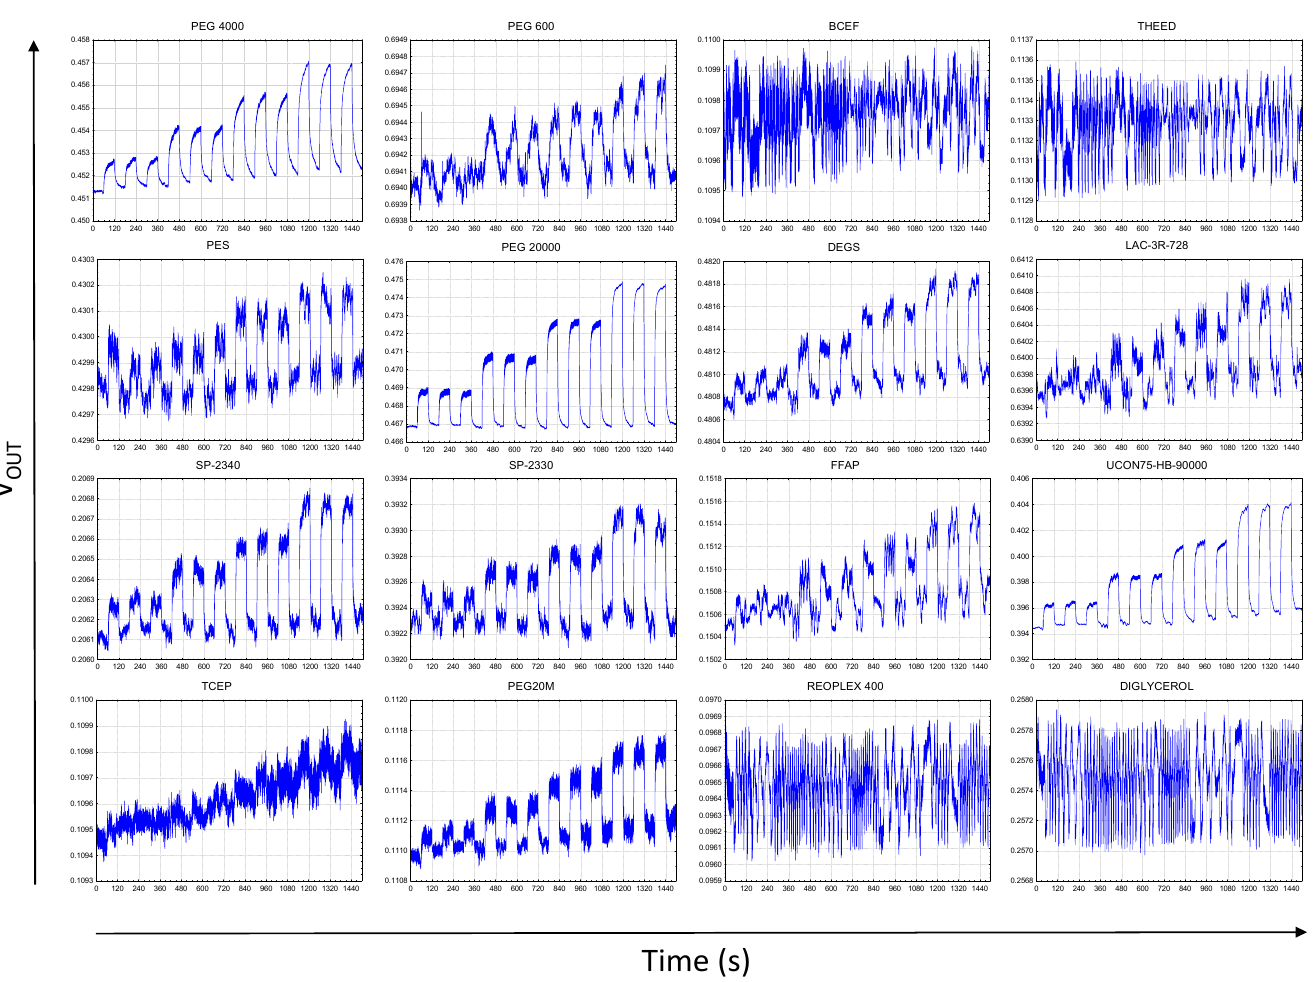
Figure 10. Transient responses of 16-channel chemosensitive resistor microchip sensor to pyrrole (carrier gas: dry nitrogen).